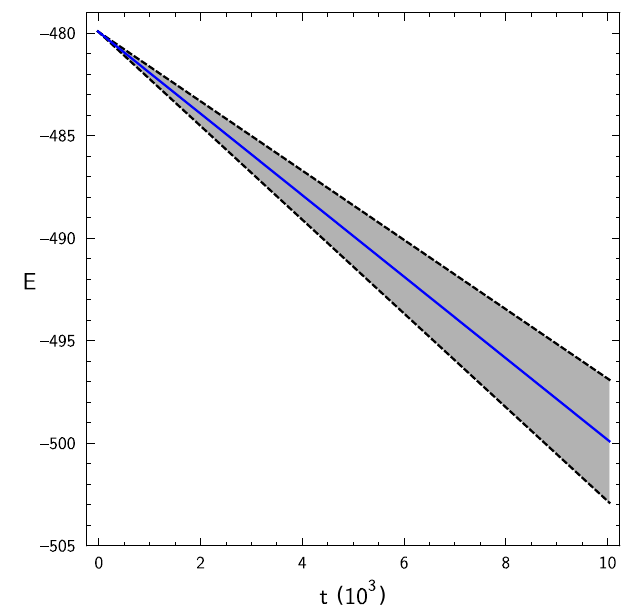
Fig. 2. Evolution of the value of the time-dependent Hamiltonian as a function of time for 10000 orbits initiated at the phase ( R; ˙ R ) space with E 0 = (cid:0) 480. The blue line indicates the average Hamiltonian change, while the black, dashed lines delimit the boundaries of the energy variation dE